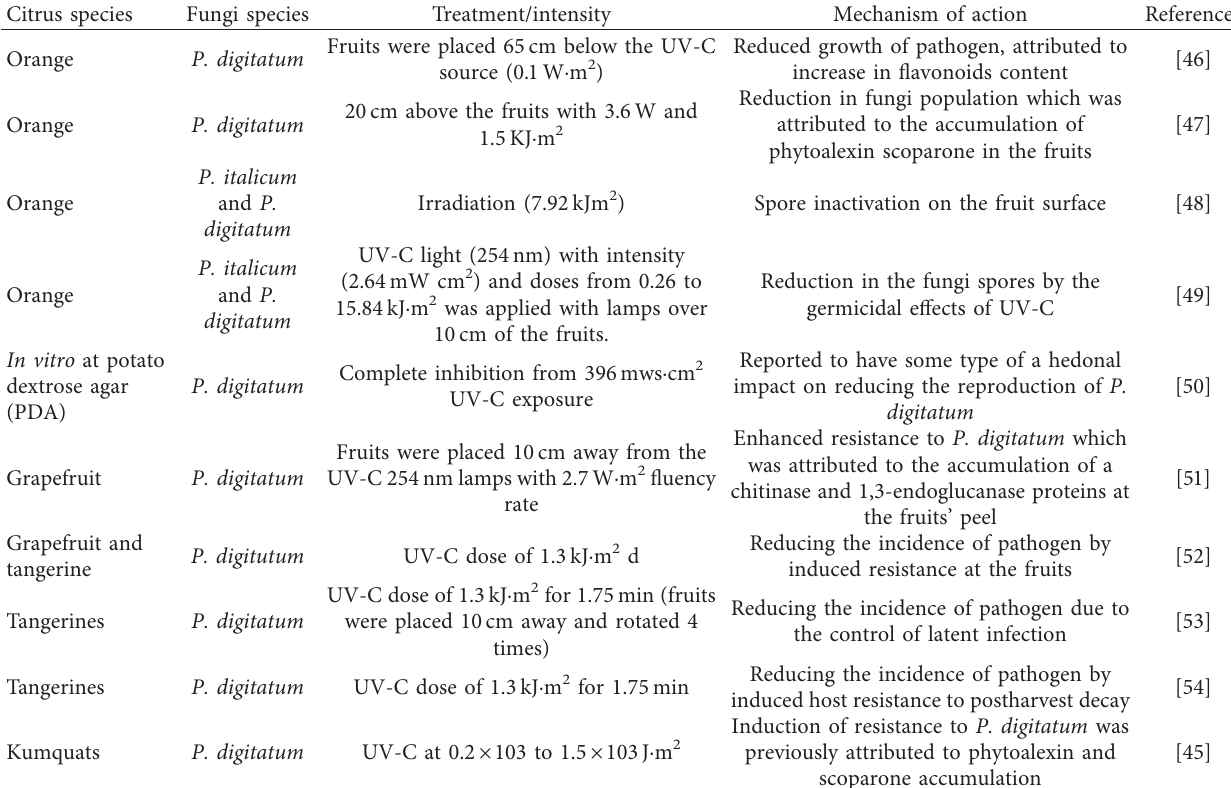
Table 1: Effects of UV-C irradiation on the postharvest rotting caused by P. italicum and P. digitatum . Citrus species Fungi